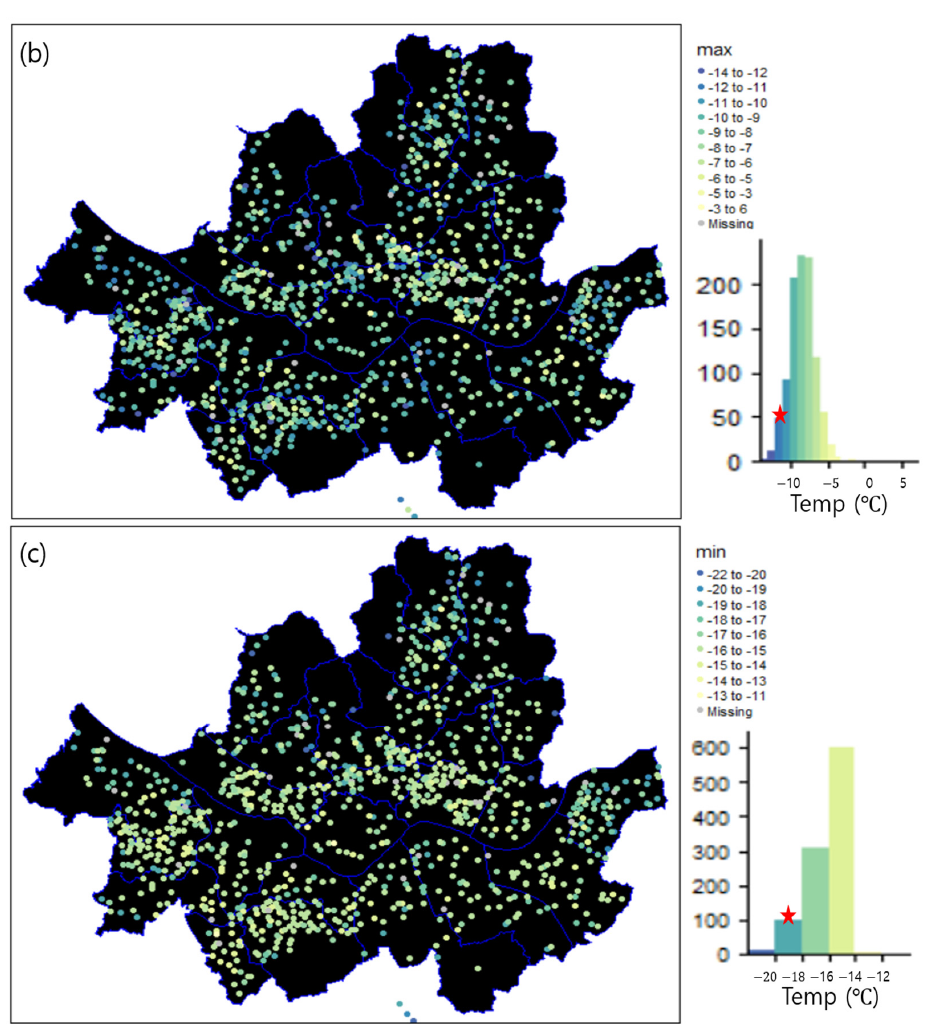
Figure 6. Horizontal distribution of daily ( a ) mean, ( b ) maximum, and ( c ) minimum temperatures on 8 January 2021, obtained by the S-DoT IoT meteorological sensors. The occurrence frequency for temperature is shown in the right bottom histogram. The values observed by Seoul ASOS are indicated by a red